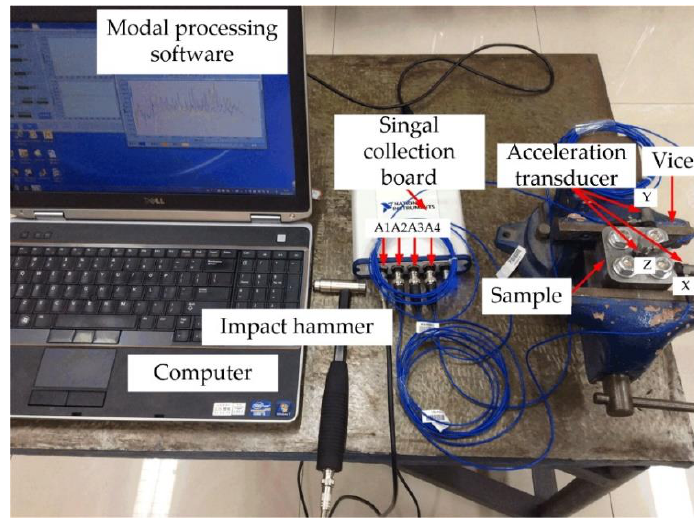
Figure 8. The principle of the modal experiment.